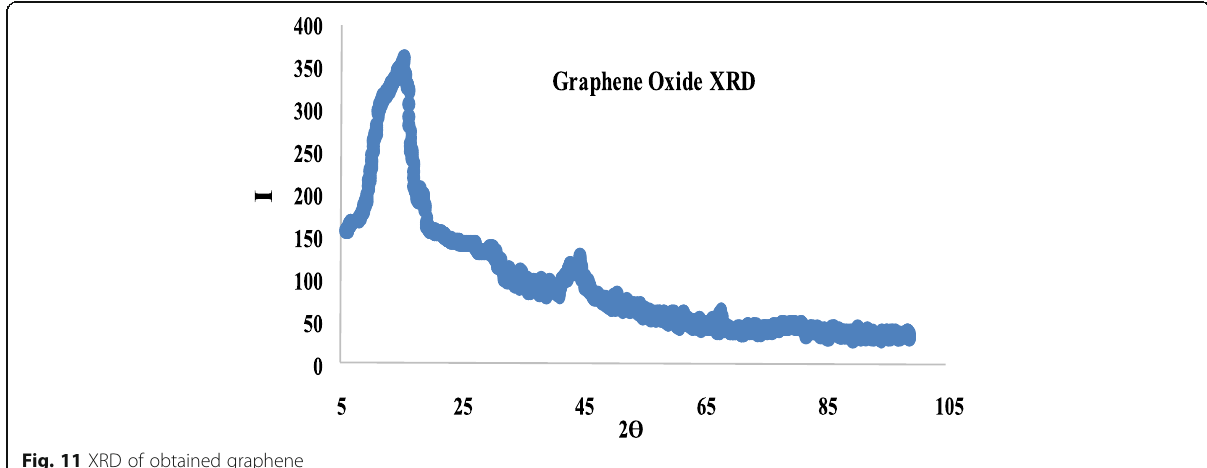
Fig. 11 XRD of obtained